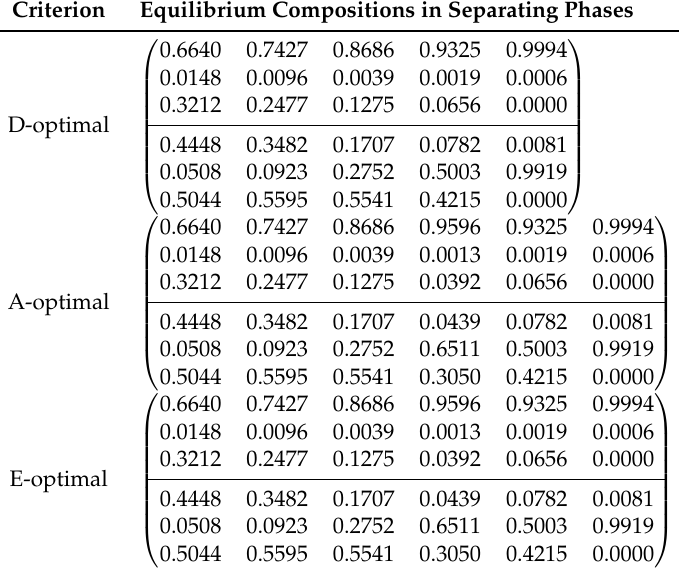
Table 2. Optimal experimental designs for ternary system WAT-TOL-ANL (compositions in equilibrium